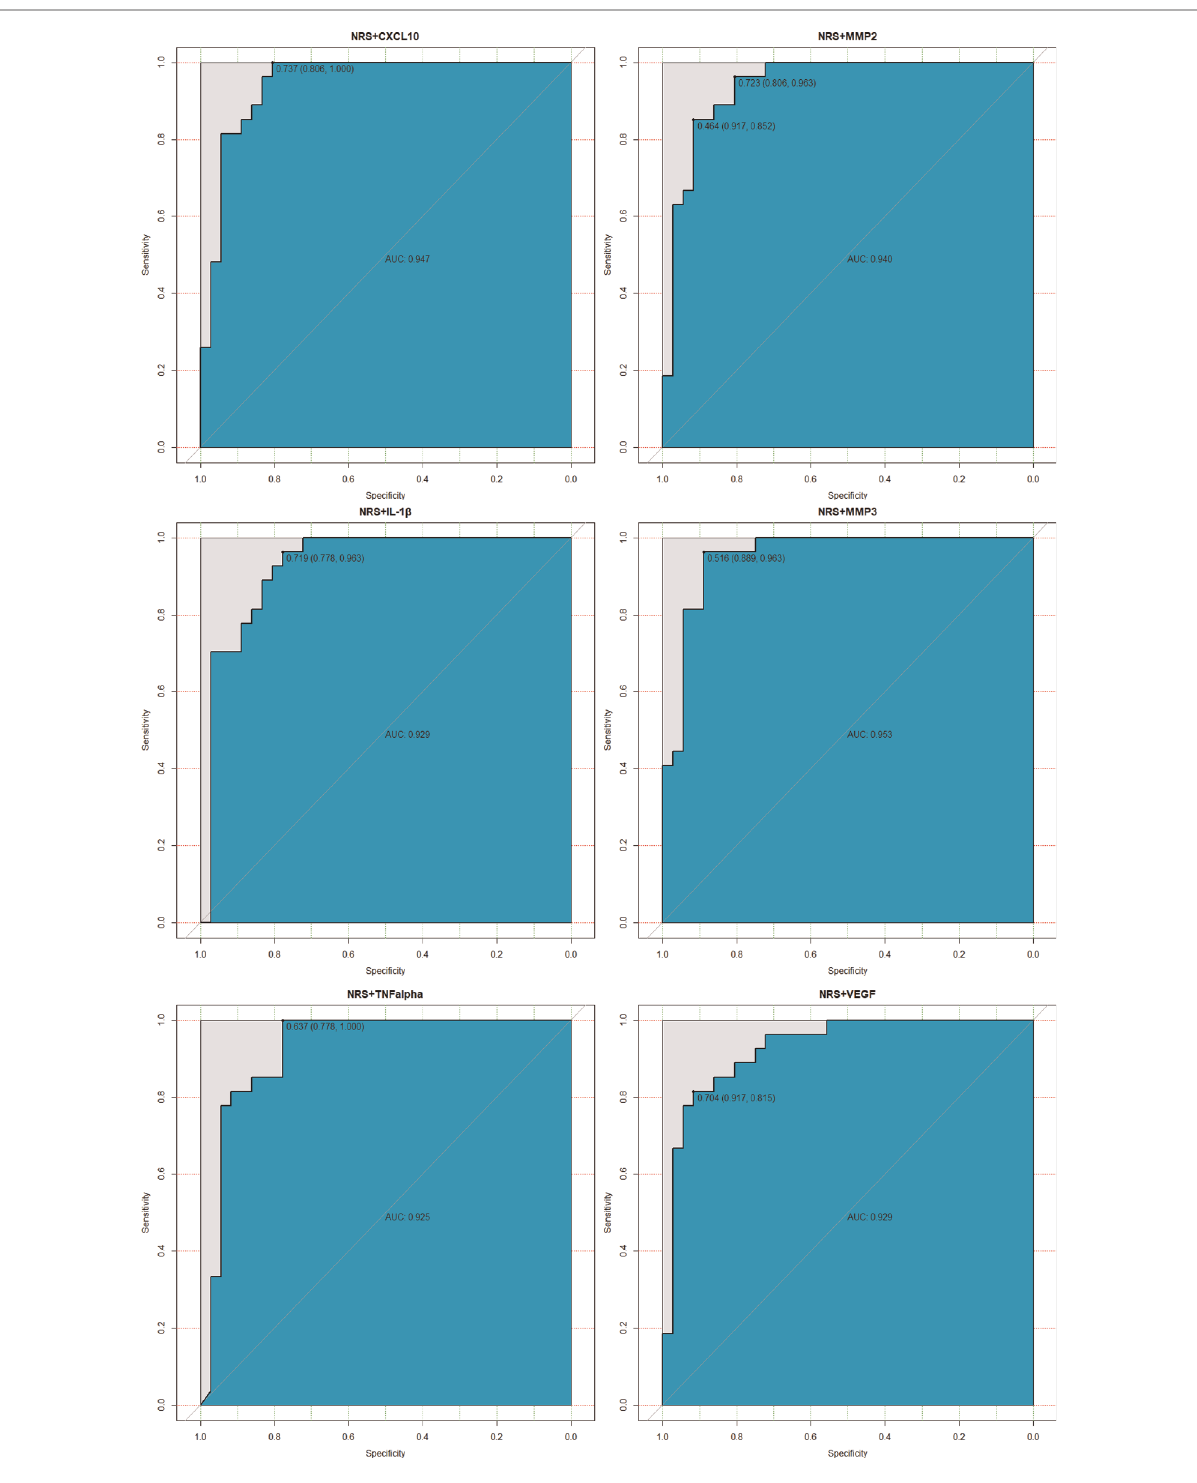
FIGURE 4 Performances of the fi nal SVM model (NRS+MMP3) in Set 1 comparing with the other model. The panel showed their ROC performances. The models ’ features were shown in subplots ’ head. The panel demonstrated that the fi nal model of using NRS and MMP3 with the best performance. ROC, receiver operating characteristic; AUC, the area under the ROC